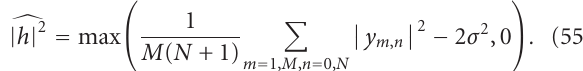
Figure 13: Bit-error performance with dominant subtrellis approach for di ff erent values N , M = 8 and L = 5 iterations.